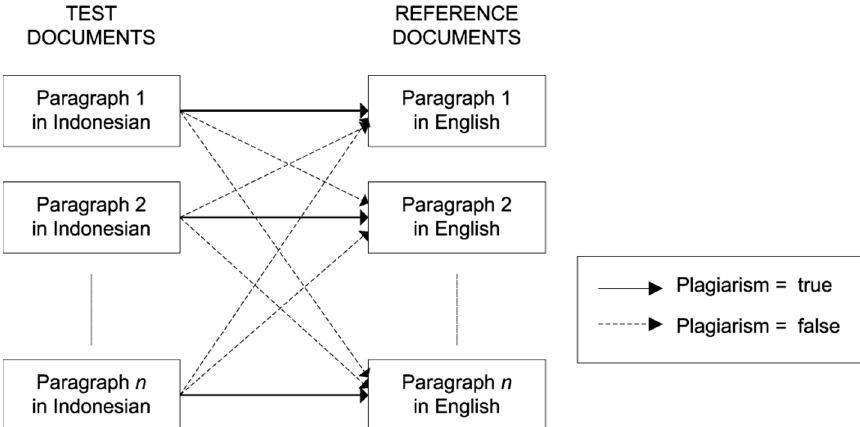
Figure 5. Testing scenario for each paper for the system developed.